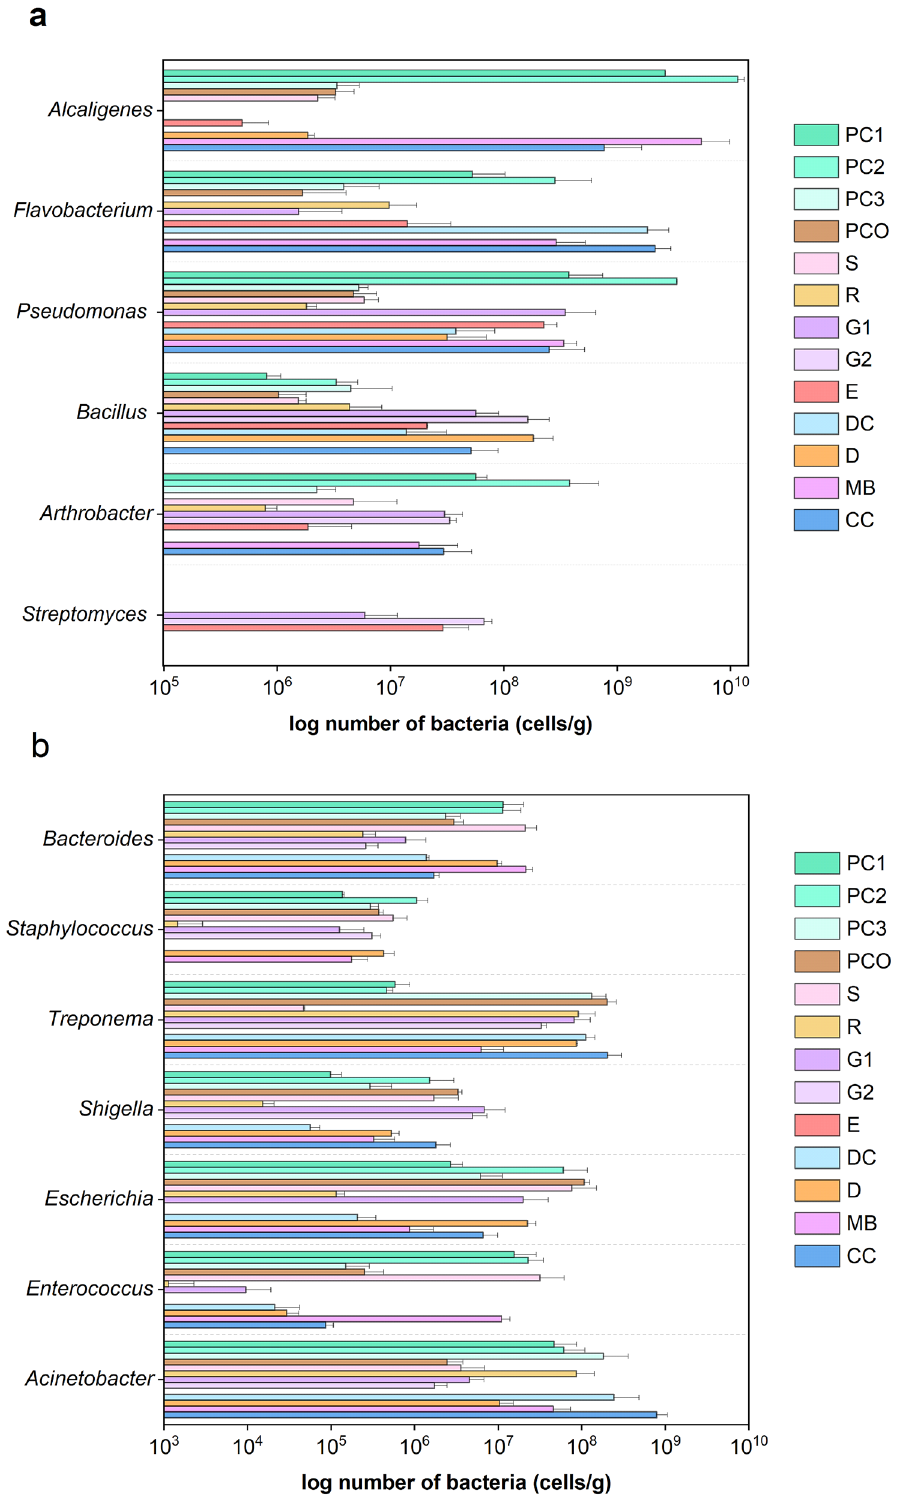
Figure 4. Comparative number of bacterial genera categorized as plant ( a ) symbiotic or ( b ) pathogenic genera across the different animal manures. Data represented mean ± S.D. List of bacteria categorized as plant symbionts and pathogens were downloaded from the Virulence Factor Database